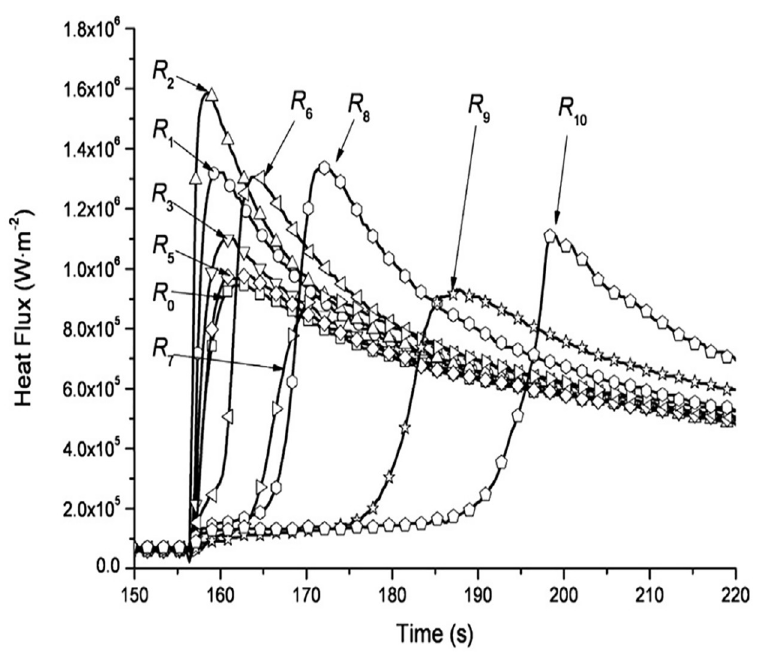
Fig 24. Heat flux of the water jet